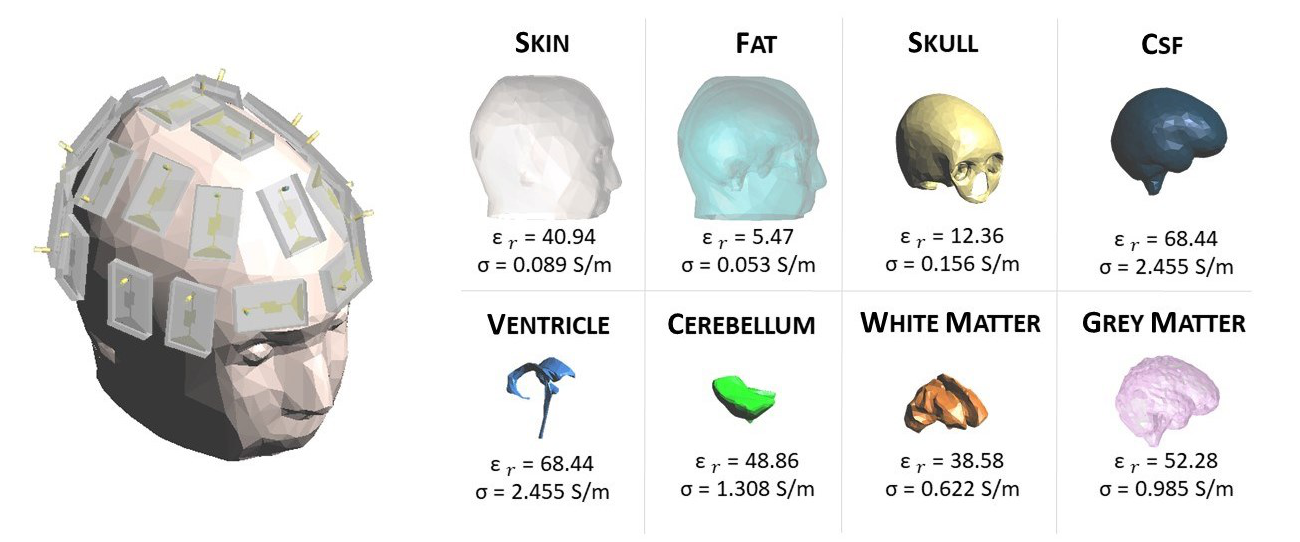
Figure 1. On the left: the MWI system; on the right: all the tissues embedded in the 3D anthropomor- phic phantom with their dielectric properties at 1GHz